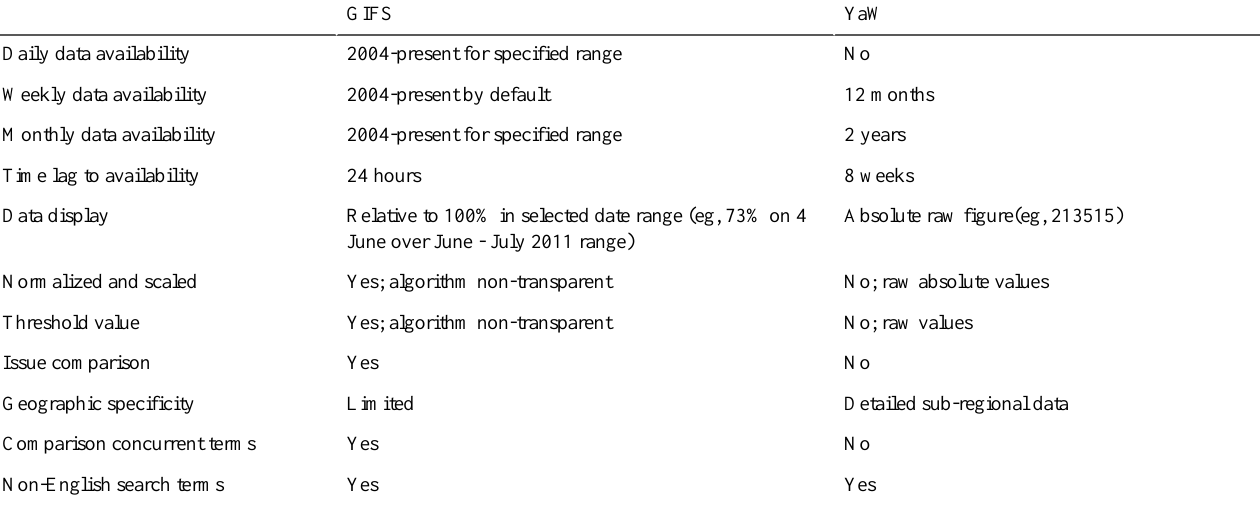
Table 1. Comparison of GIFS and YaW.